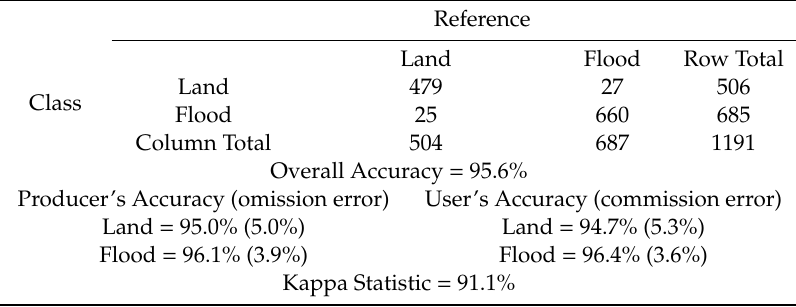
Table 2. Classification accuracy of the maximum flood extent product mapped from Planet high-resolution optical